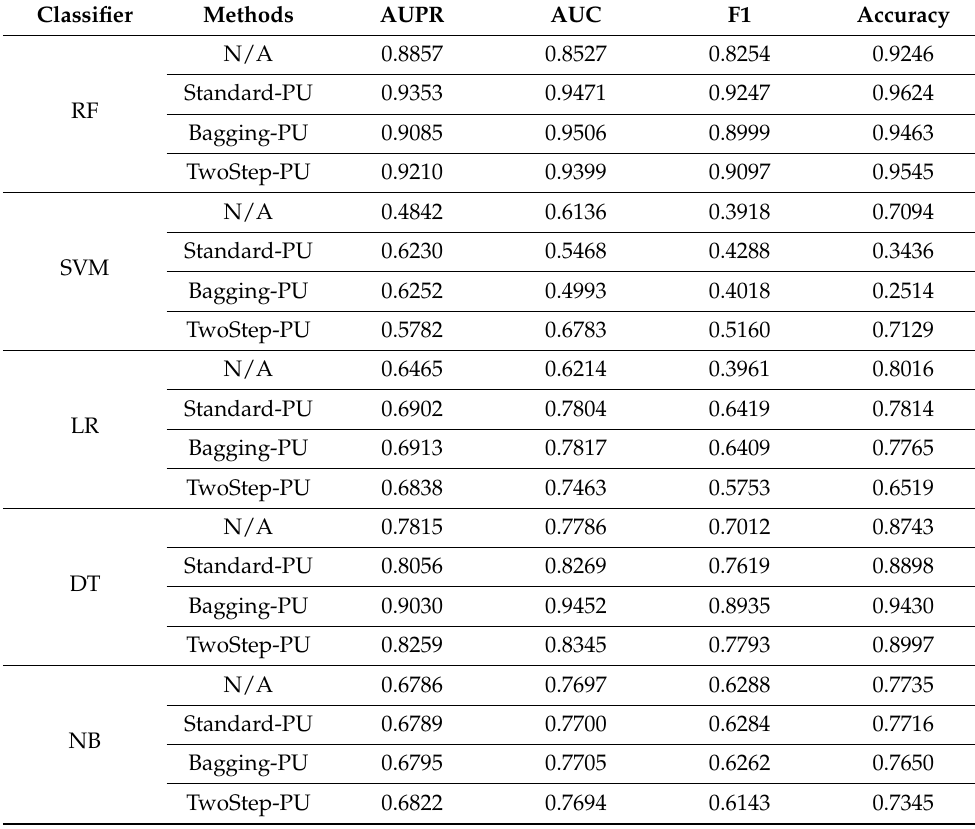
Table 2. The performance of positive-unlabeled learning methods using different classifiers on the DrugBank